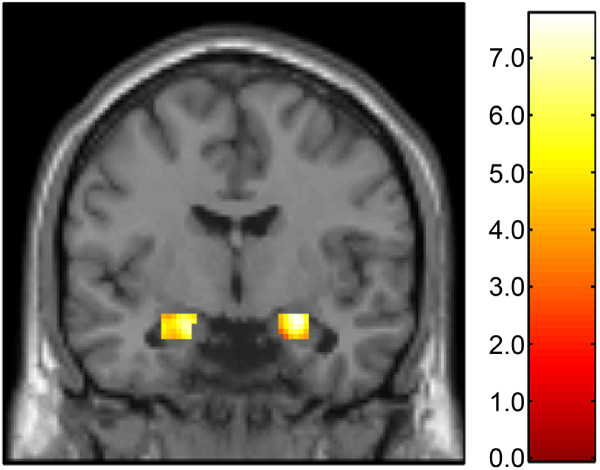
Amygdala reactivity to perceptual processing of fearful and angry facial expressions. Statistical parametric map representing bilateral amygdala clusters exhibiting a significant response to task (faces > shapes; right amygdala: (24, -6, -11), z = 6.28, k = 145 voxels (P < 0.05, corrected); left amygdala: (-18, -7, -15), z = 5.77, k = 146 voxels (P < 0.05, corrected). Color bar indicates t-scores.